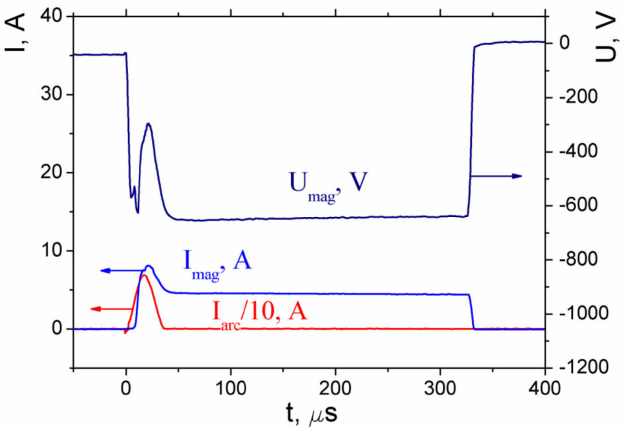
Figure 3. Magnetron discharge voltage and current, vacuum arc current. Pb magnetron target, Pb arc